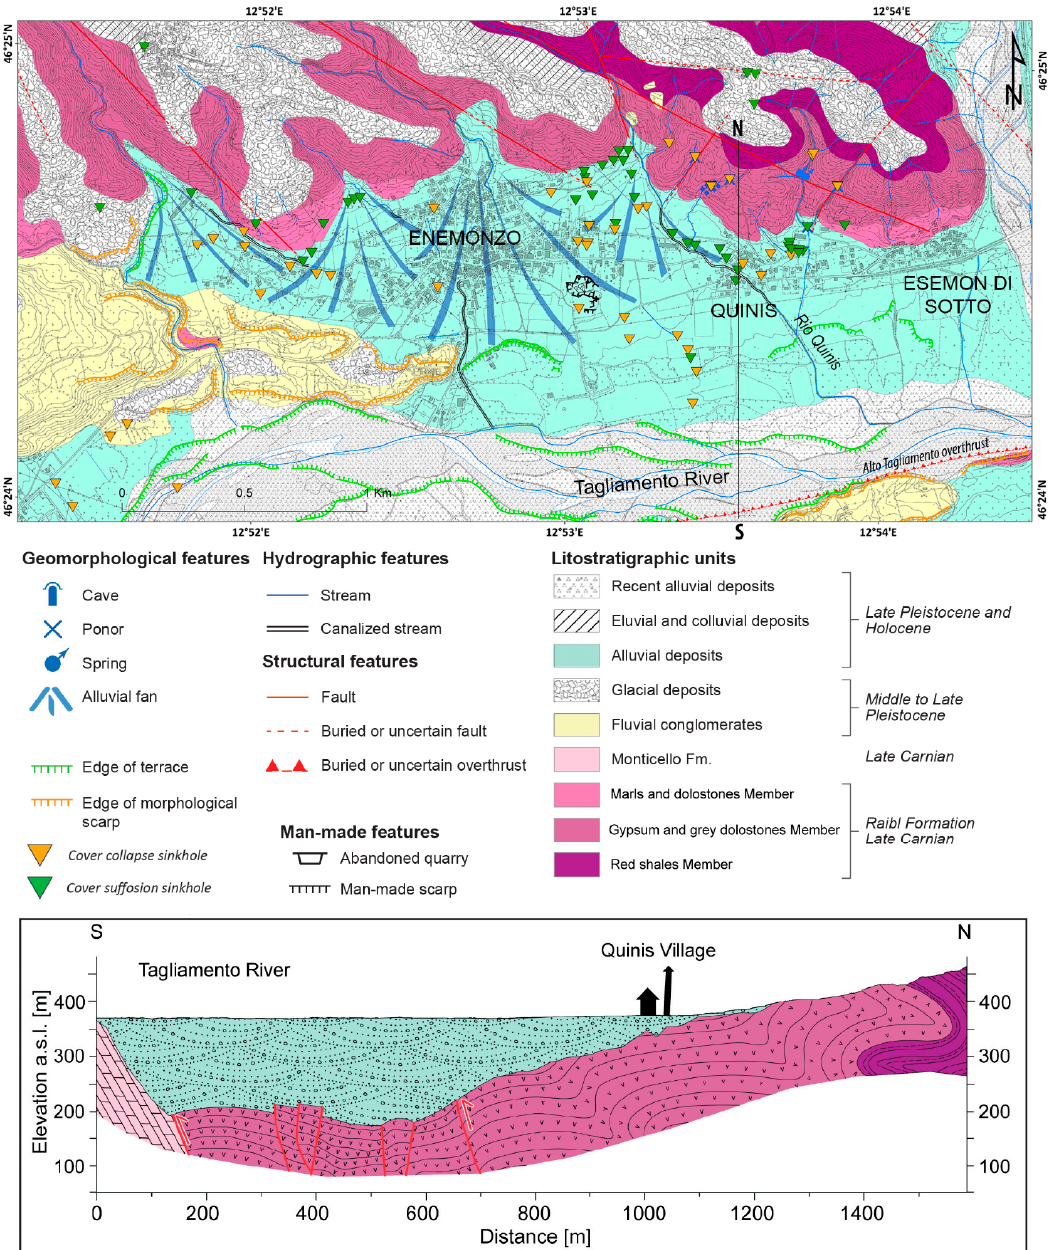
Figure2. Geologicalandgeomorphologicalmapofthestudyareaandtherelatedsimplifiedcross-section Figure 2. Geological and geomorphological map of the study area and the related simplified cross-section (modified after [11]. (modified after